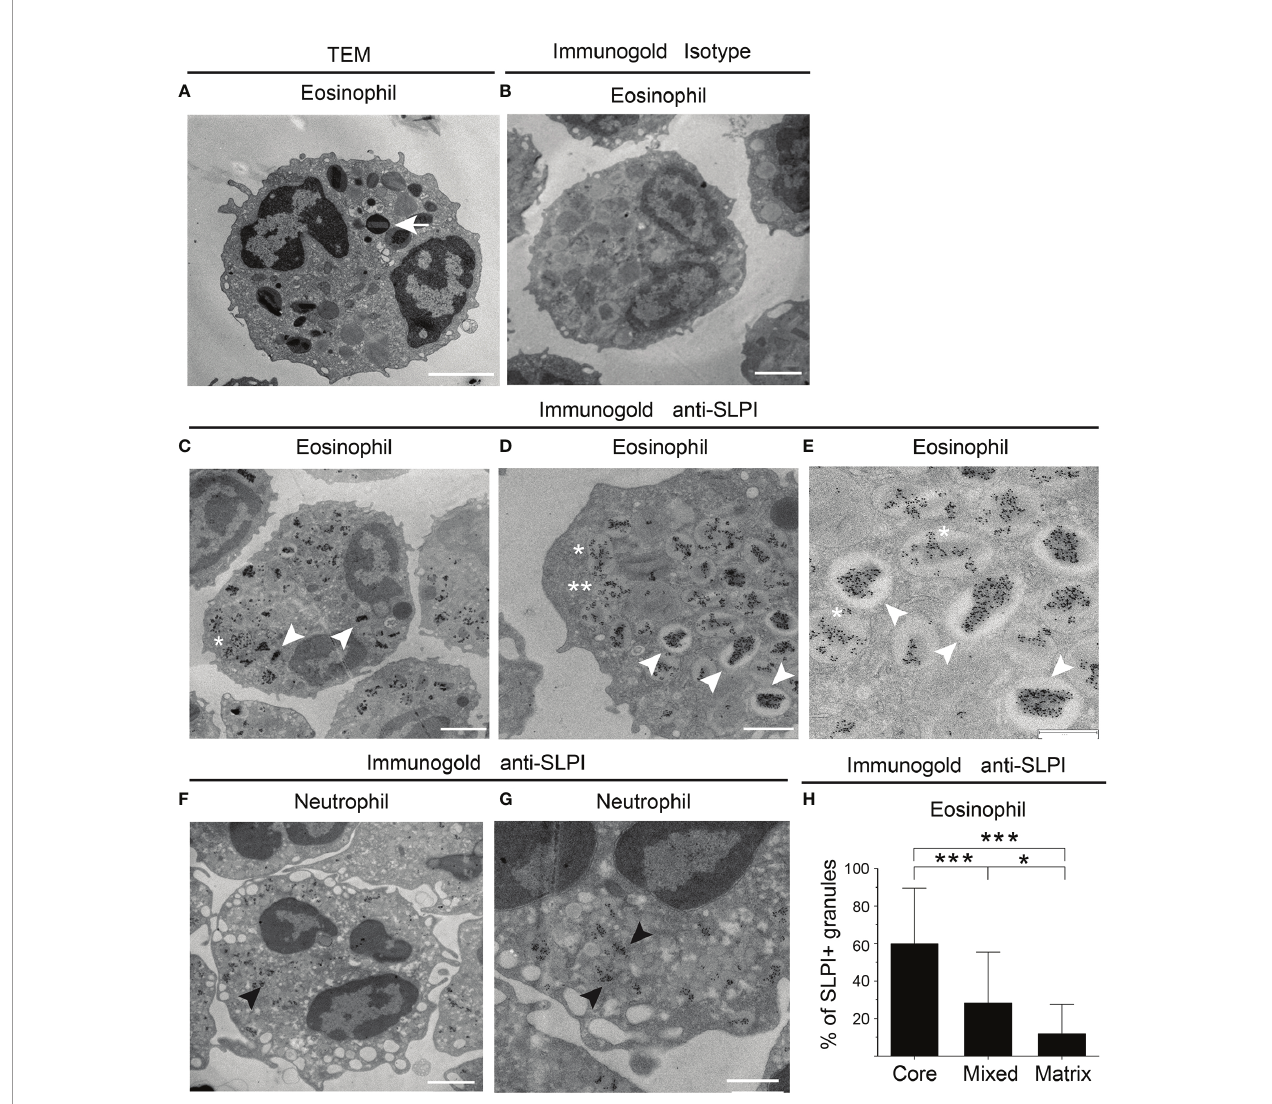
FIGURE 4 | SLPI mainly localizes to eosinophil crystalline cores. The granulocytes indicated from healthy donors were subjected to conventional TEM (A) or immuno-electron microscopy (B – H) using biotinylated mouse anti-human SLPI mAbs or isotype control mAbs followed by mouse anti-biotin mAbs and gold-labeled donkey anti-mouse Abs. (A) The ultrastructure of eosinophil is depicted by TEM with characteristic crystalline core in the granule (arrow). (B) Isotype control for SLPI staining in eosinophils. (C – E) Localization of SLPI to crystalline core in eosinophils (white arrowheads), crystalline core and matrix (mixed localization, asterisk), or granule matrix (double asterisks), revealed by immunogold staining for SLPI and shown at lower- and higher-power magni fi cation. (F, G) Immunogold localization of SLPI in neutrophils shown at lower- and higher-power magni fi cation (black arrowheads). (H) Average distribution per single cell of granules with the indicated SLPI localization in electron micrographs. The mean ± SD, n = 17 eosinophils from two donors is shown, *p < 0.05, ***p < 0.001 by ANOVA, with post hoc Tukey test. Scale bar = 2 m m (A – C, F) , 1 m m (D, G) , or 0.6 m m (E)